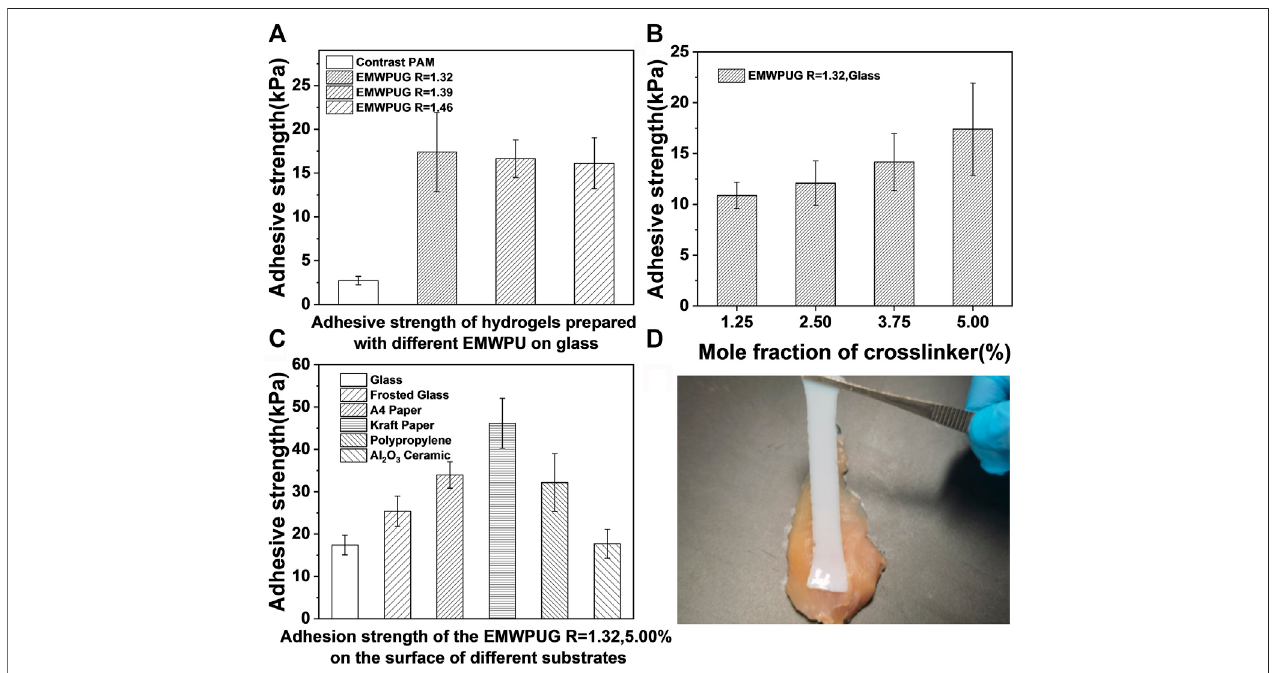
FIGURE 4 | Adhesive strengths of the hydrogels with (A) diverse EMWPU R values and (B) different mole fractions of crosslinker (EMWPU R = 1.32) on glass. (C) Adhesive strengths of EMWPUG R = 1.32 at 5.00 mol fraction adhered to the surfaces of various materials. (D) Adhesion to chicken muscle tissue of hydrogels.